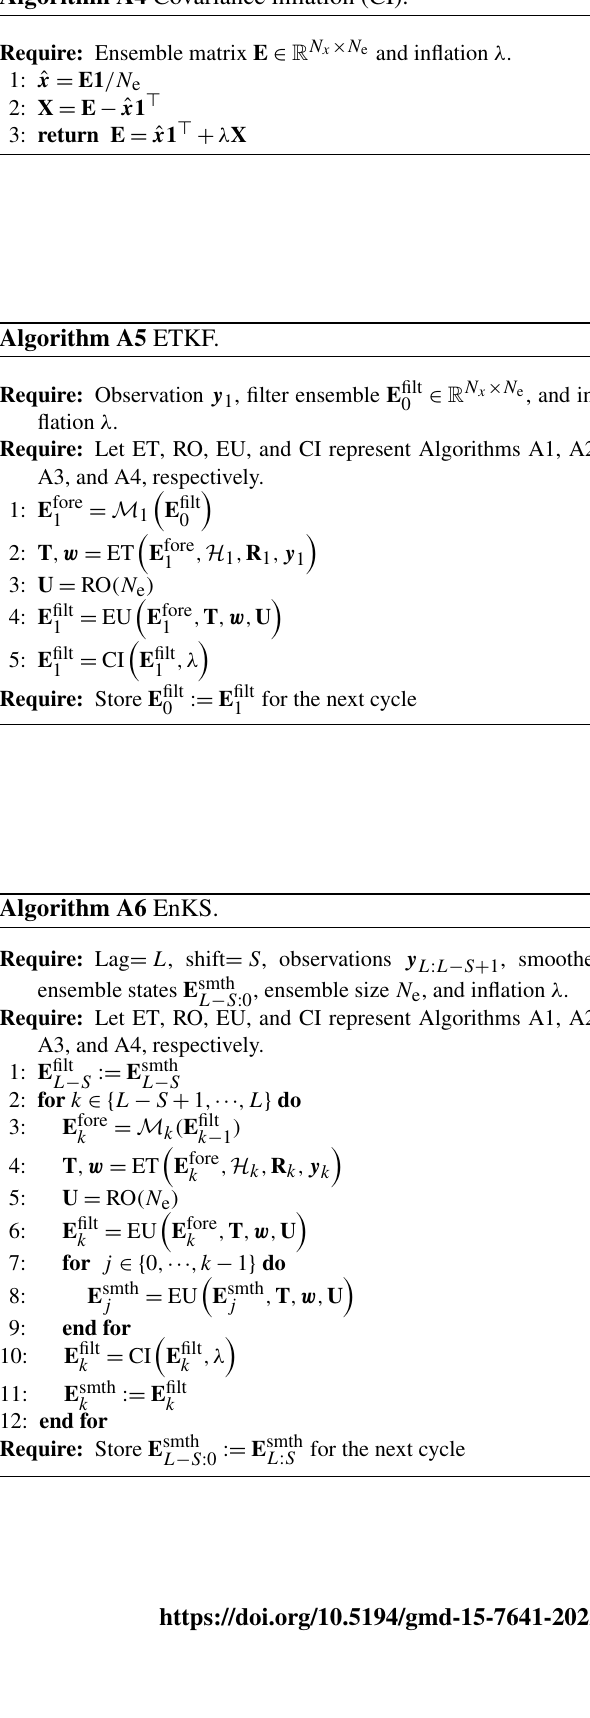
Algorithm A4 Covariance inflation (CI).